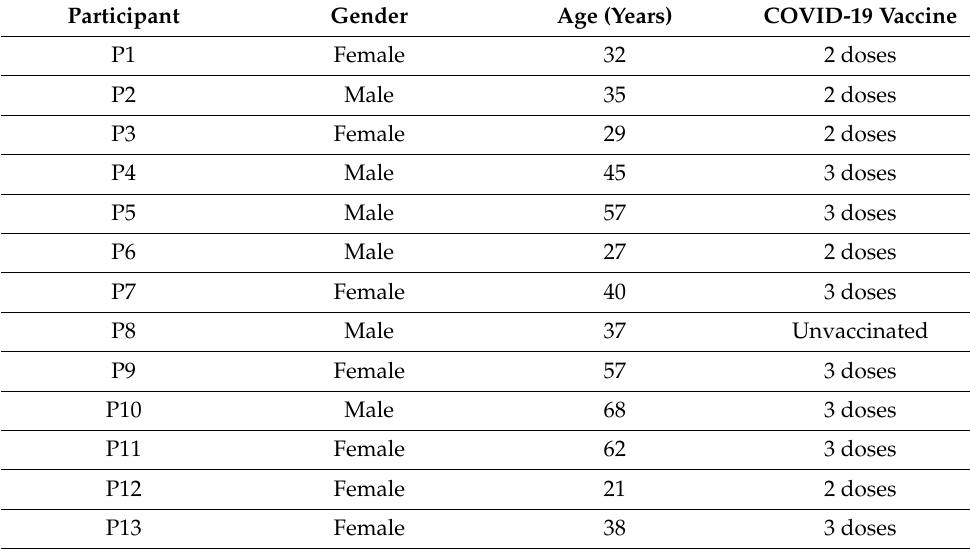
Table 1. Information about